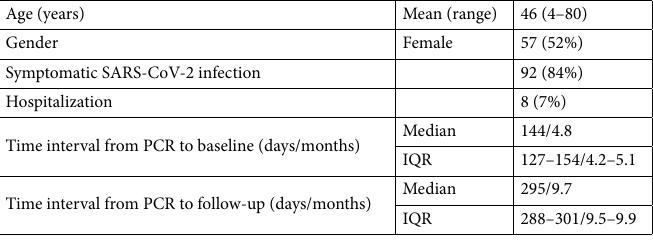
Table 1. Patients‘ characteristics. IQR interquartile range.